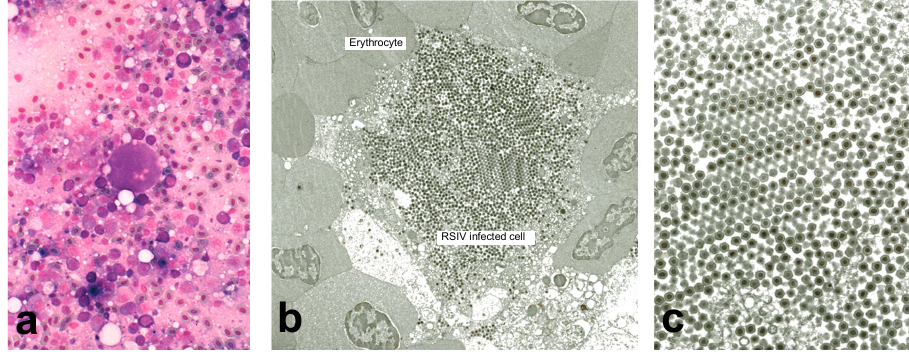
Figure 1 . ( a ) Giemsa-stained impression smears of the spleen of RSIV-infected red sea bream display enlarged cells characterized by basophilic staining. ( b ) Electron micrograph of RSIV-infected spleen cells. ( c ) Higher magnification of the virions seen in panel B. All photographs were kindly provided by Dr. K.